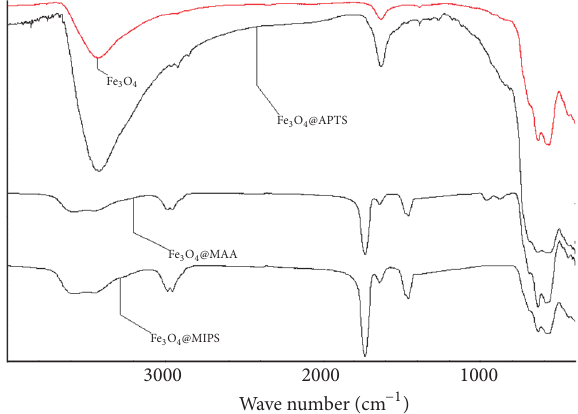
Figure 4: The FTIR of magnetic